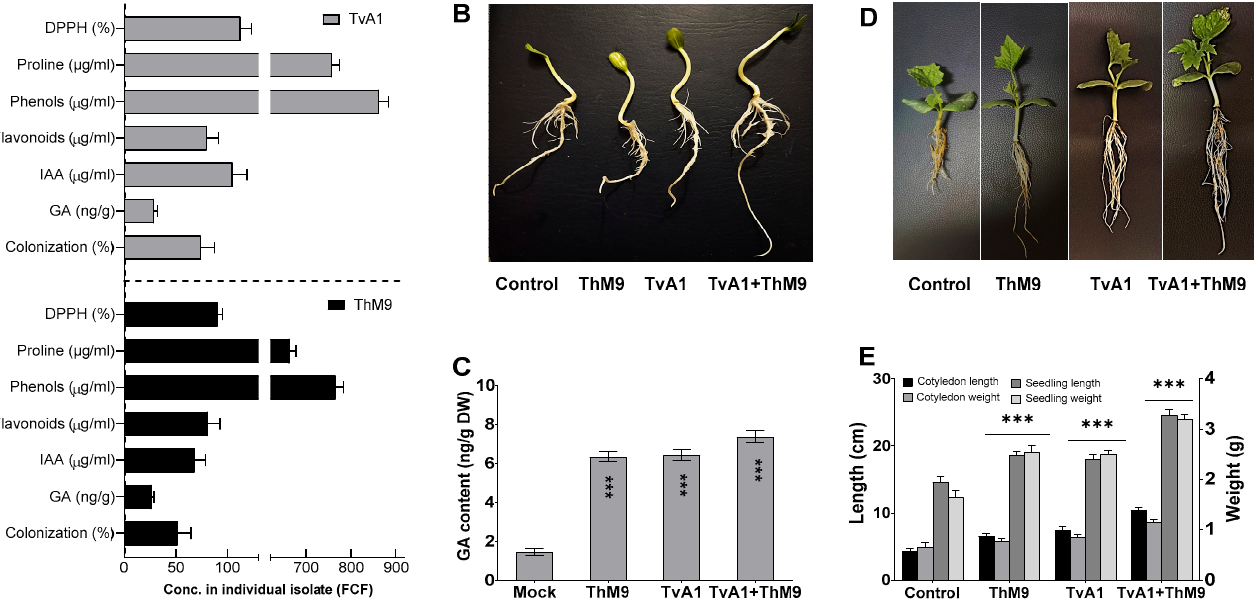
Figure 1. Characterization of ThM9 and TvA1 fungal isolates. ( A ) DPPH (%), proline, phenols, flavonoid content, IAA, GA, and root colonization. ( B ) Phenotypic analysis showing a comparison of ThM9 and TvA1 co-inoculation bioassay for germination and growth potential. ( C ) GA content in luffa seedling upon ThM9 and TvA1 co-inoculation bioassay. ( D ) Phenotypic analysis showing the comparison of ThM9 and TvA1 co-inoculation bioassay for plantlets of luffa. ( E ) Growth kinetics of luffa seedlings upon ThM9 and TvA1 co-inoculation bioassay. Quantitative data represent the means ± SD (n = 12) of three independent experiments. The asterisks indicate represents a significant difference between treated samples compared to control (*** p ≤ 0.005). FCF, fungal culture filtrate; DW, dry weight.